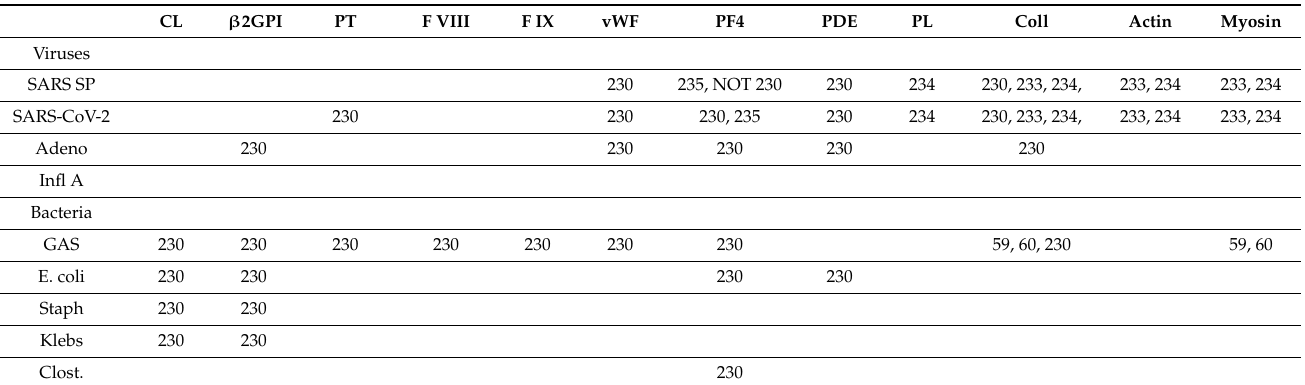
Table 3. Experimentally verified evidence for the binding of antibodies against various viruses and bacteria (left-hand column) with human protein antigens associated with autoimmune coag- ulopathies, myopathies and vasculopathies (rows). CL = cardiolipin; β 2GPI = beta 2 glycopro- tein 1; PGP1b = platelet glycoprotein 1b; PT = prothrombin; F VIII = factor VIII; F IX = factor IX; vWF = von Willebrand factor; PF4 = platelet factor 4; PDE = phosphodiesterase; PL = phospholipid; Coll = collagen; SARS SP = SARS-CoV-2 spike protein; Adeno = adenovirus; Infl A = influenza A; Clost = Clostridium species; Staph = Staphylococcus aureus; Klebs = Klebsiella pneumoniae; E. coli = Escherichia coli; GAS = group A Streptococci. Blank entries indicate that there are no known reactions between human antibodies or sera to a given microbial antigen that cross-reacts with the corresponding human